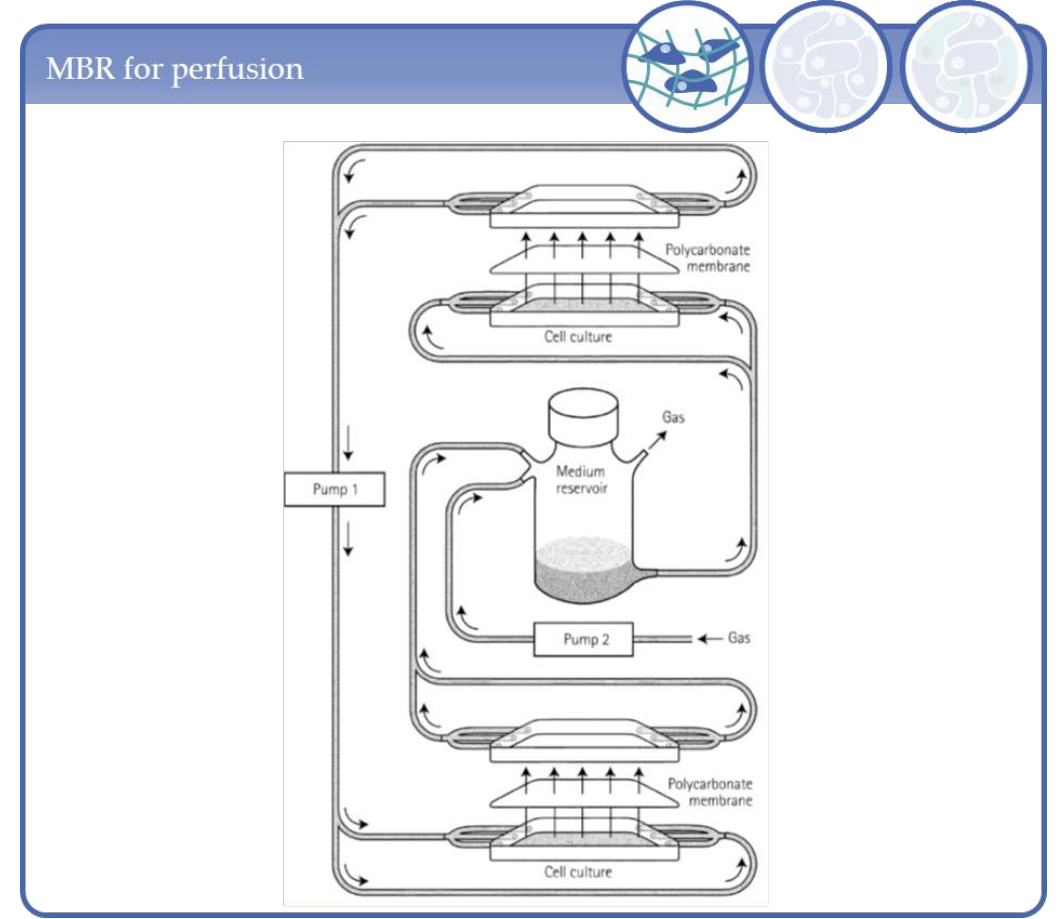
Figure 3. MBR with perfusion chambers and closed circulation loop for improved nutrient supply. Silicon tubes connected two spatial separated bioreactor compartments in one common system. The pump performs the medium perfusion between compartments with possibility for variable flow and pulsation rate. The multiple inputs and outputs permit optimized medium flow distribution. Reprinted from [14] with permission of Elsevier.